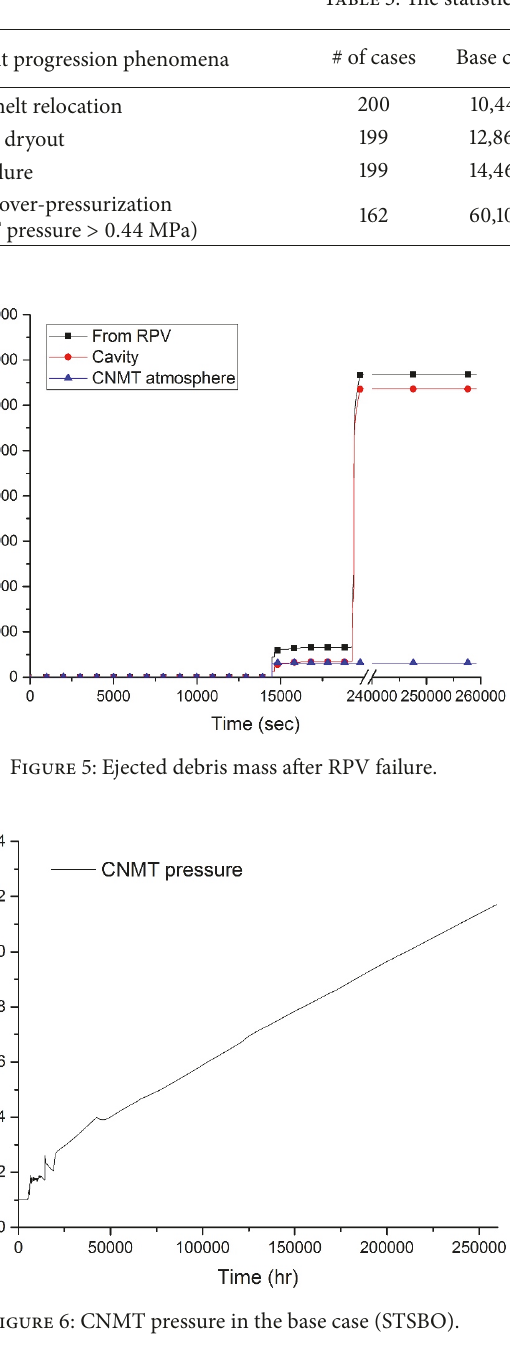
Table 3: The statistics values of accident progress.